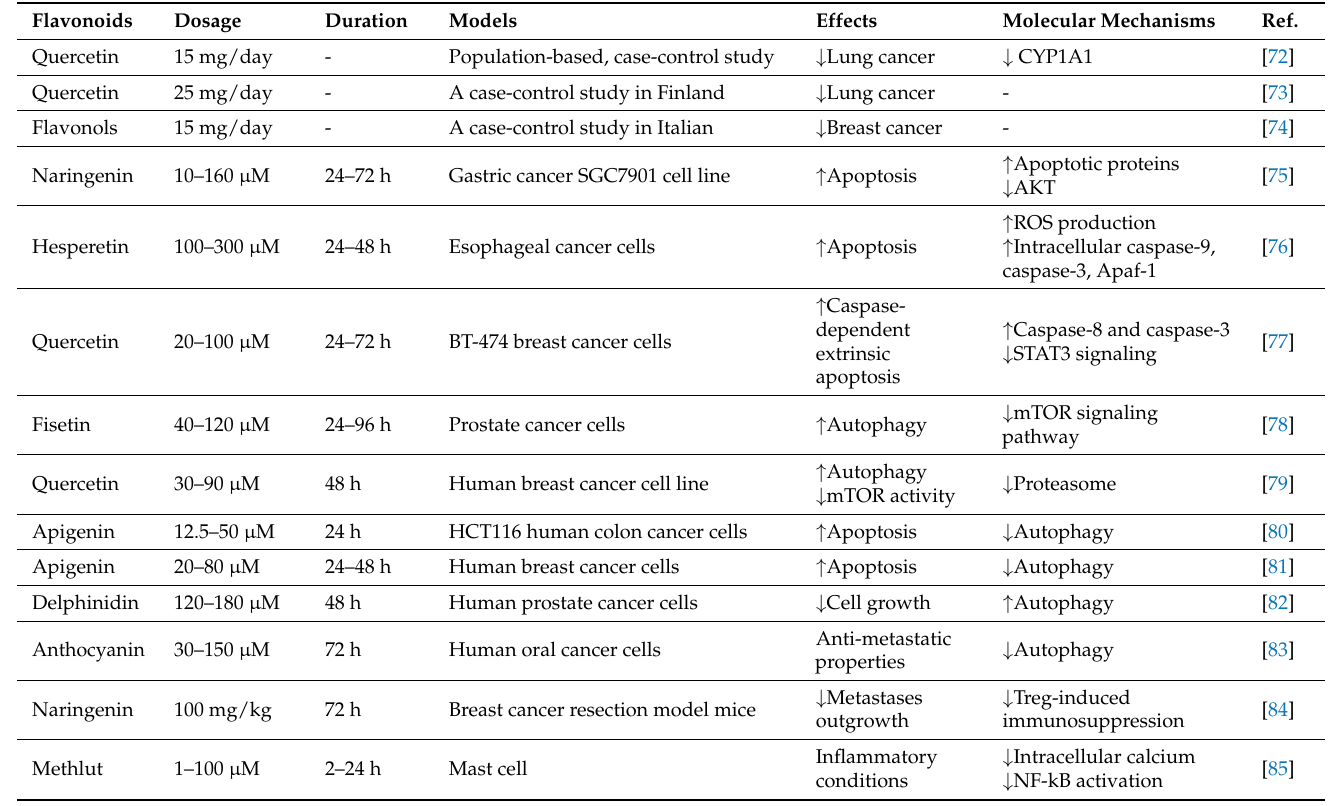
Table 2. Anti-carcinogenic roles of flavonoids in the clinical study and experimental